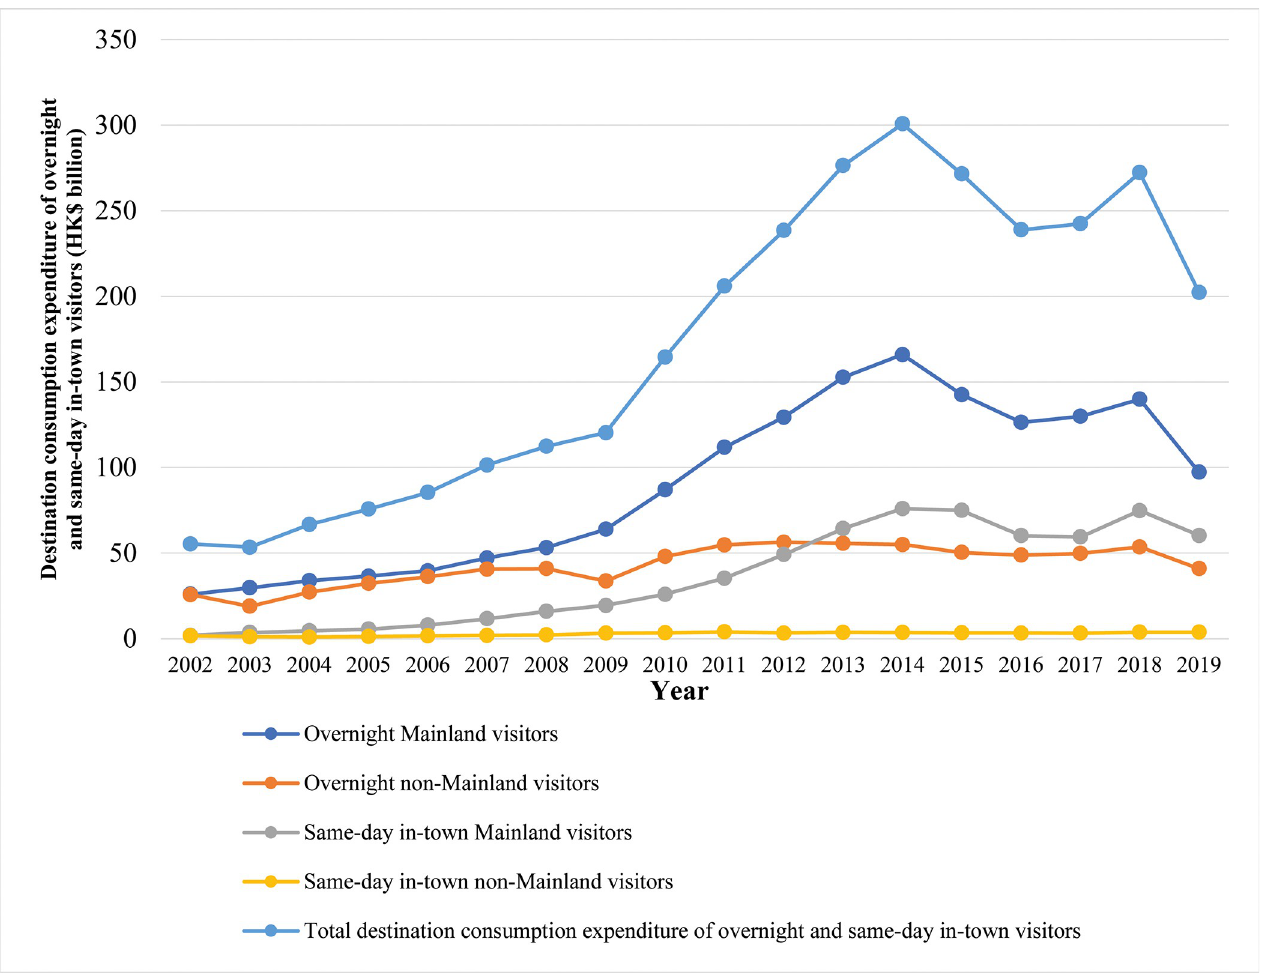
Fig 4. Tourist spending by same-day and overnight visitors to Hong Kong, 2002–2019. Data source: Hong Kong Annual Digest of Statistics. https://www.